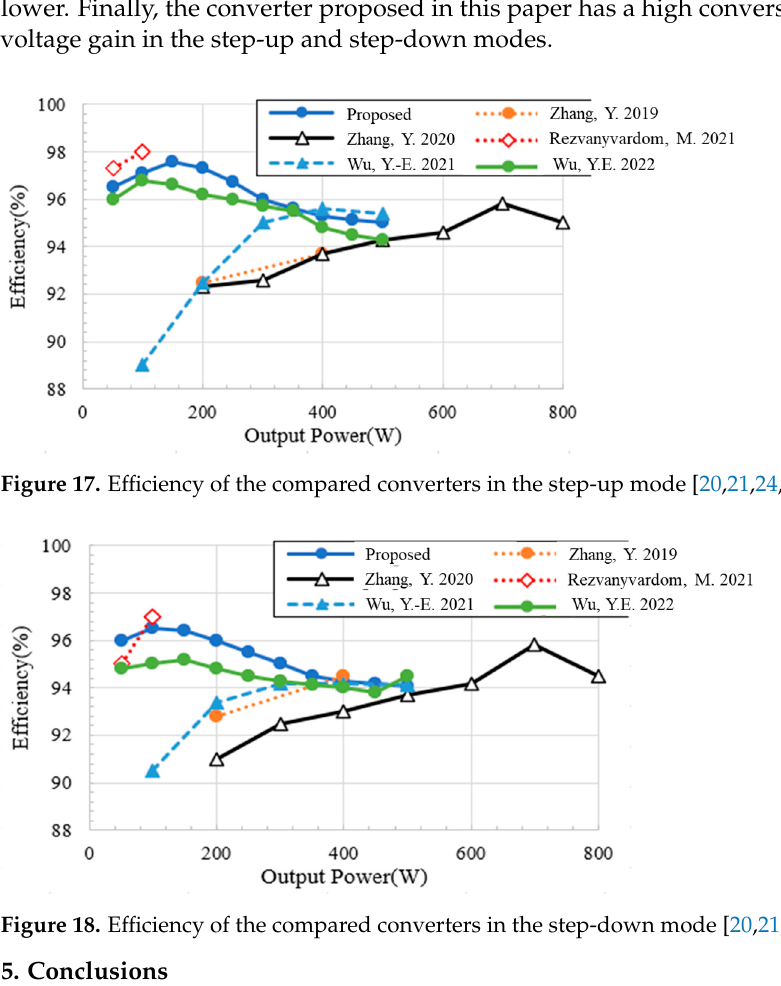
Figure 18. Efficiency of the compared converters in the step-down mode.